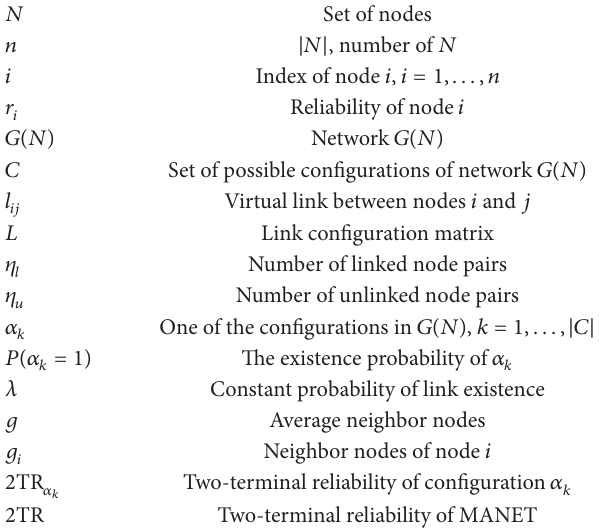
Table 1: Definition of